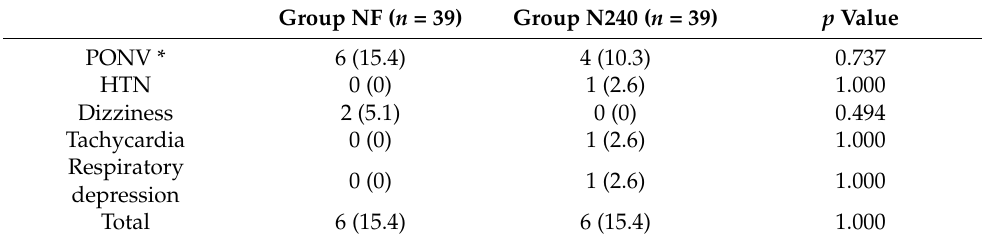
Table 4. Adverse